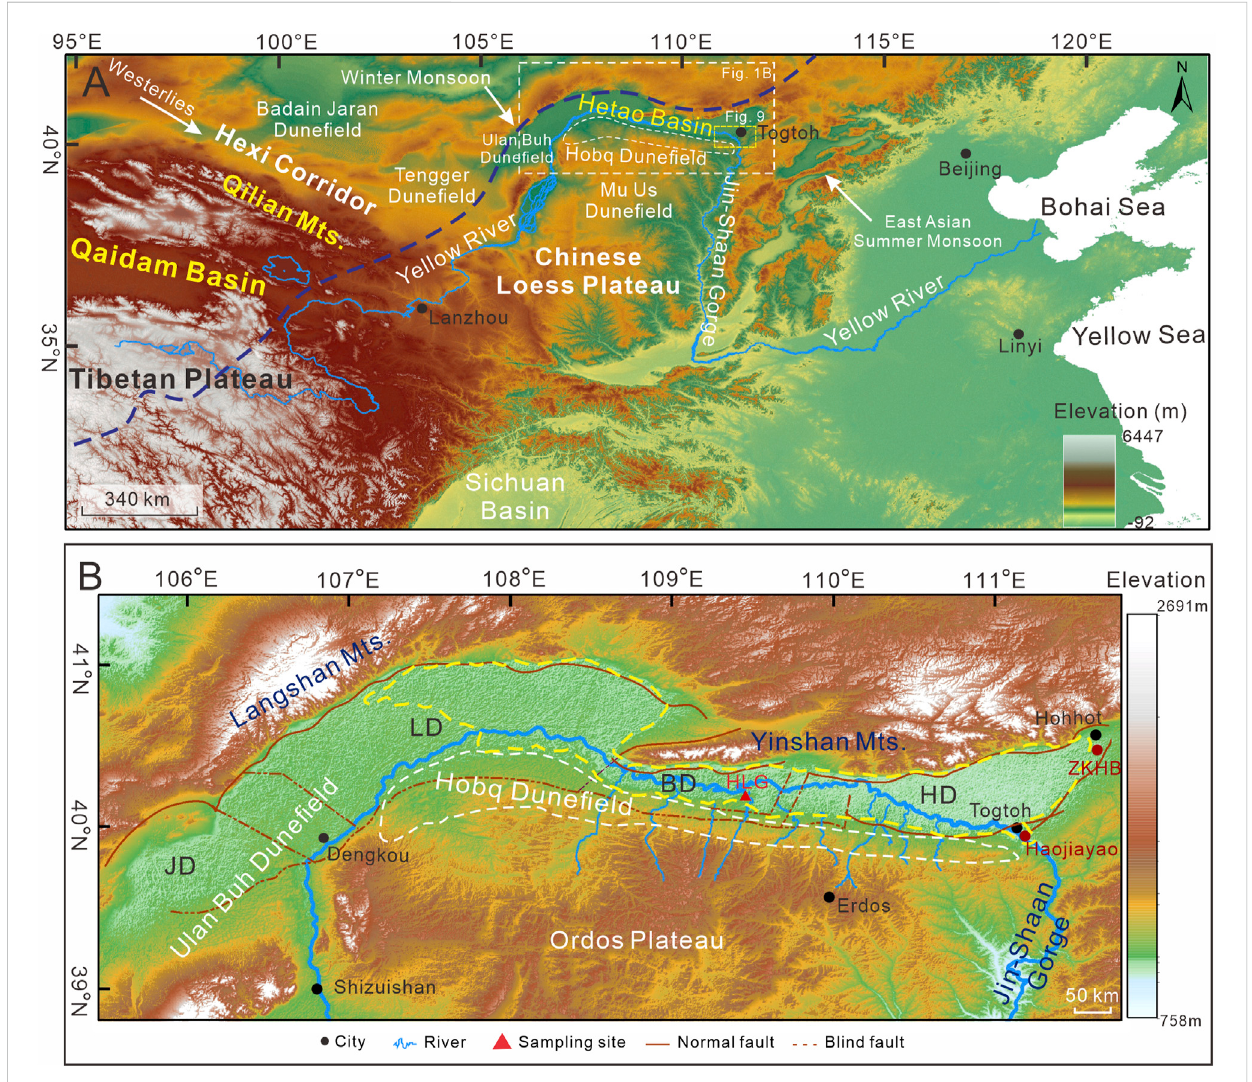
FIGURE 1 Geographic setting of the Hetao Basin. (A) Location of study area, major atmospheric circulation systems, and boundary of the EASM (dotted blue line). (B) DEM shows morphology of regions around the Hetao Basin, including modern drainage system of the Yellow River, and the faults (red lines) (modi fi edfromCEA, 1988)dividing thebasinintofoursub-basins:Jilantai (JD),Linhe(LD),Baiyanhua(BD),andHohhotDepressions(HD).The locationof ZKHB and Haojiayao cores (red dots) are also marked. Reconstructed possible area (dotted yellow line) of the HTPL according to the modern contour line of 1033 m